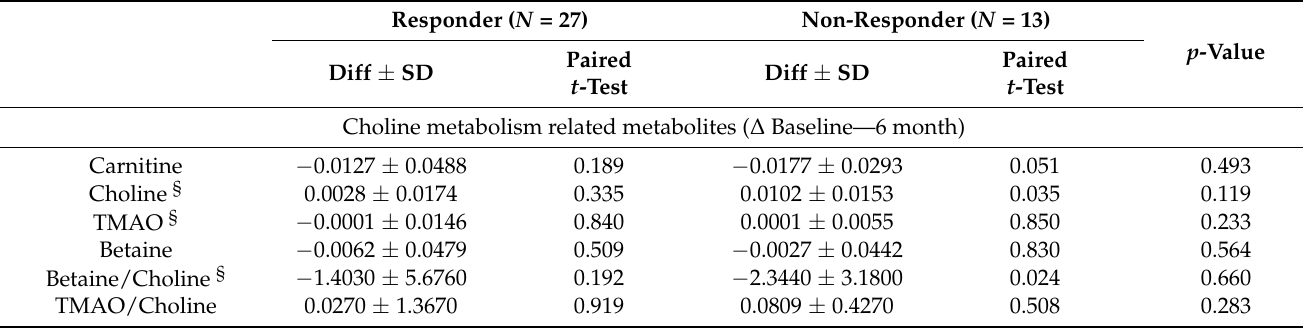
Table 2. Changes in metabolites related to choline metabolism after lifestyle intervention.